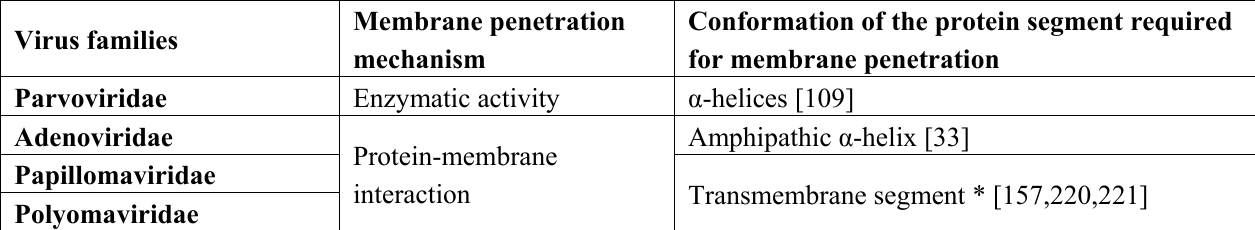
Table 4. Summary of the mechanisms used for membrane penetration by selected non-enveloped virus